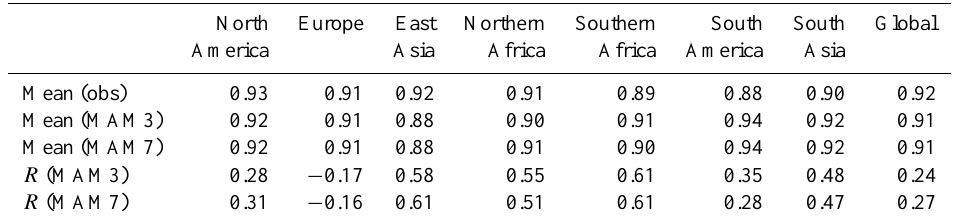
Table 10. Mean of observations (obs) and model simulations, and correlation coefficients ( R) between model simulations and observations, for SSA over the seven regions in Fig.